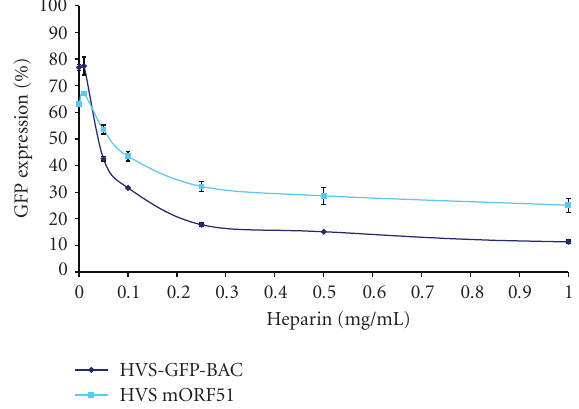
Figure 10: Soluble heparin blocks HVS-GFP-BAC entry in Huh7.5 cells and inhibits HVS mORF51 to a lesser extent. Cells were incubated with a range of concentrations of heparin in 5% media for 1h prior to infection with virus (also in 5% media). 48 h after infection, cells were removed from their wells, and GFP fluorescence was measured by flow cytometry ( n = 2). Concentrations of heparin over 0.05 mg/ml resulted in viral cell entry being inhibited with both viruses. However, the neutralisation e ff ect is less severe with HVS mORF51, suggesting some attenuation of its heparin- binding